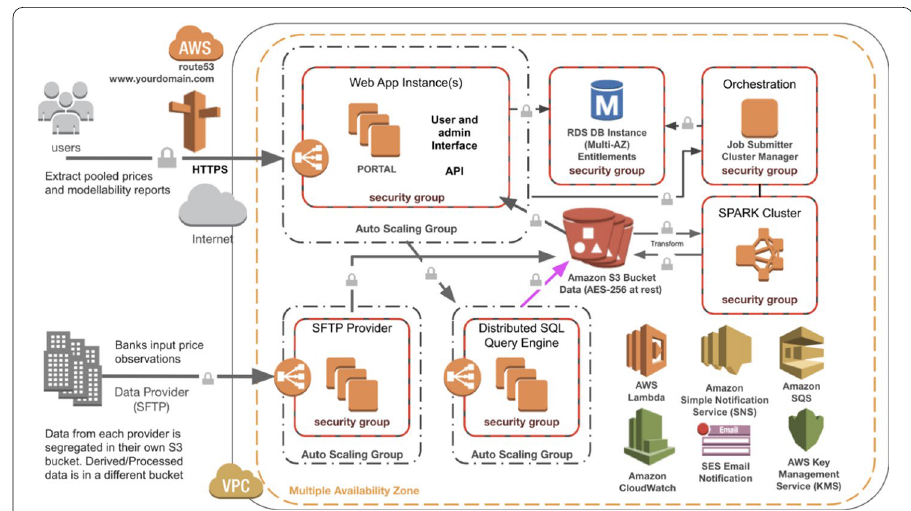
Fig. 1 TickSmith’s example data pool architecture diagram on AWS cloud. Note TickSmith. "TickSmith’s Data Pooling Solution empowers Canadian banks to anonymously share data for FRTB compliance”. https://